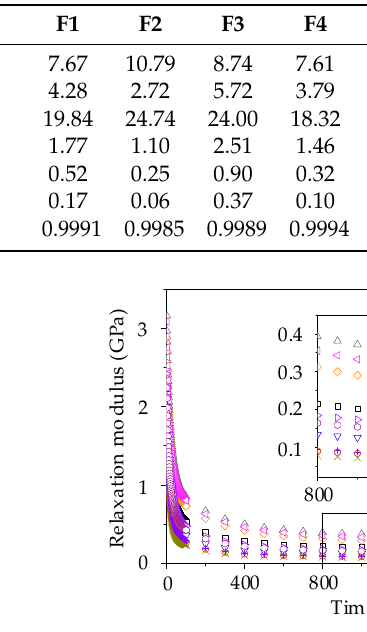
Table 8. Fitting results of Prony series for asphalt mortars.